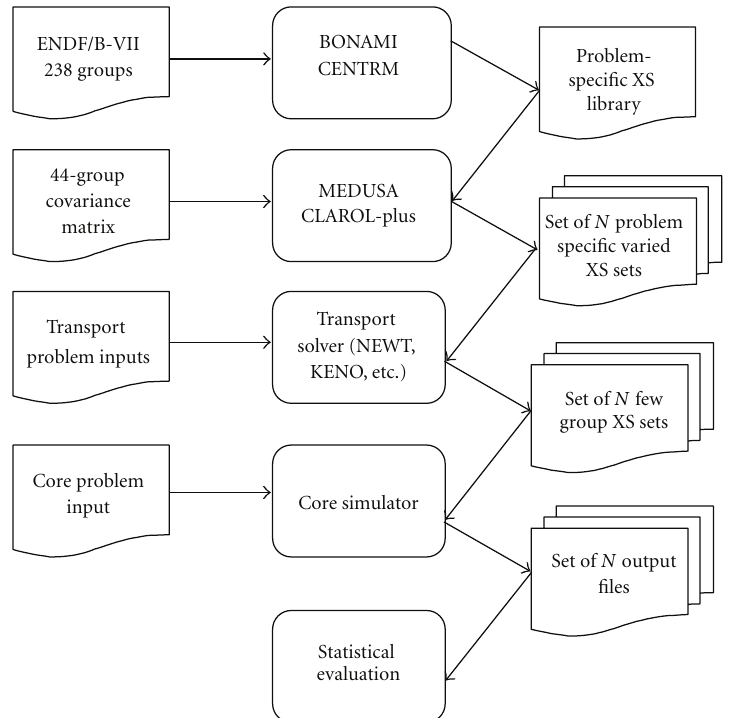
Figure 1: Flow diagram of the XSUSA approach starting from use of the ENDF/B-VII 238-group library and ending with a statistical evaluation of output